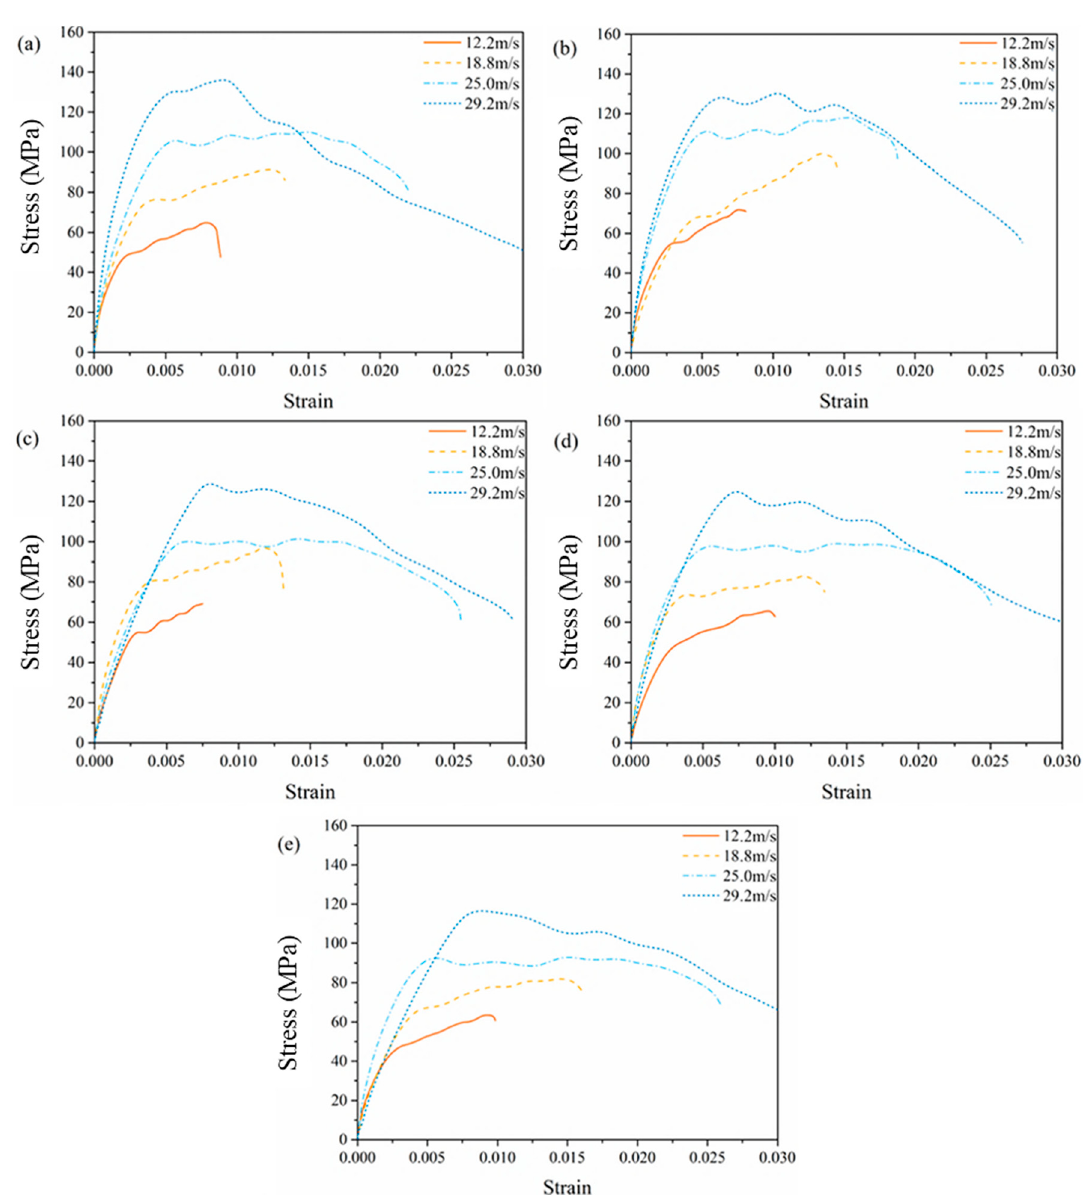
Figure 9. Average compression stress-strain curves with different equivalent aging time: ( a ) 0 years, ( b ) 1 year, ( c ) 2 years, ( d ) 4 years, ( e ) 6 Table 3. The slope of the compression stress-strain curves under different impact velocity and equivalent aging time.